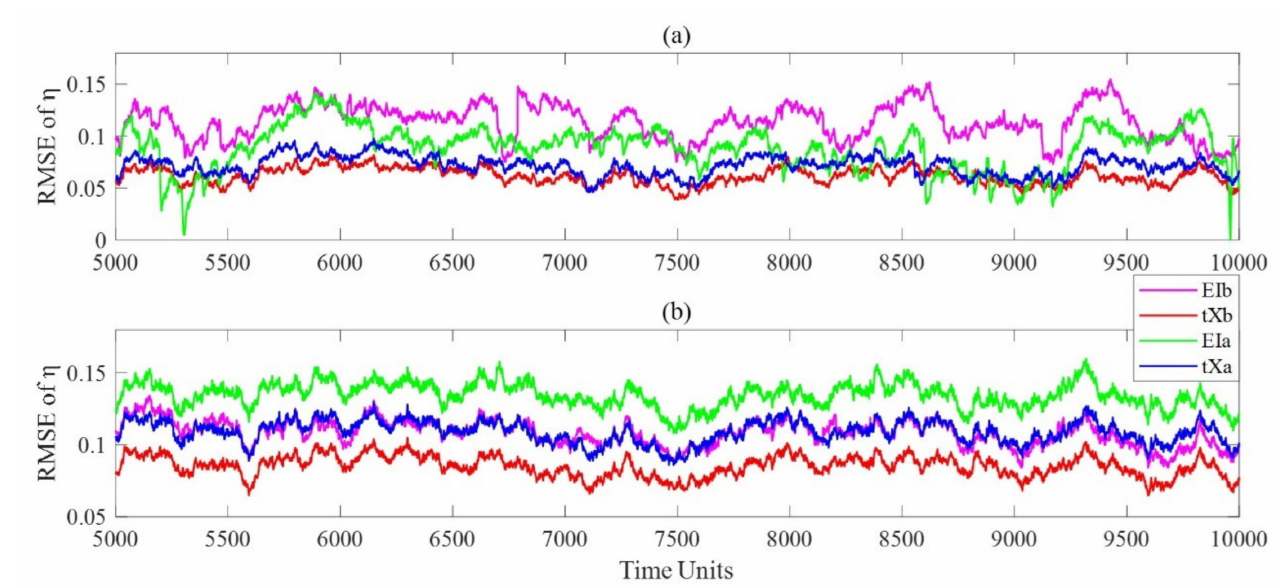
Figure 4. Time series of RMSEs of η in the last 5000 TUs in the imperfect model with EIb (magenta line), tXb (red line), EIa (green line) and tXa (blue line), with an ensemble size of 5 for ( a ) and 20 for ( b ).